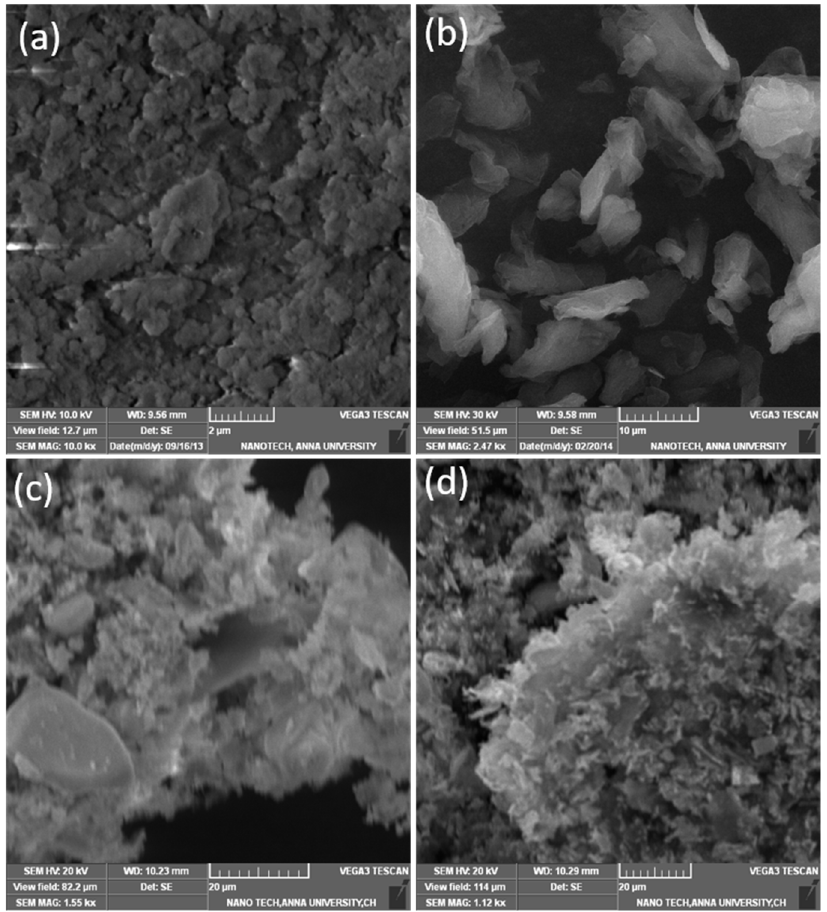
Figure 3. SEM images of ( a ) HfO 2 nanoparticles, ( b ) graphene, ( c ) HfO 2 —graphene (10 wt%) nanocomposite, and ( d ) HfO 2 —graphene (50 wt%) nanocomposites.